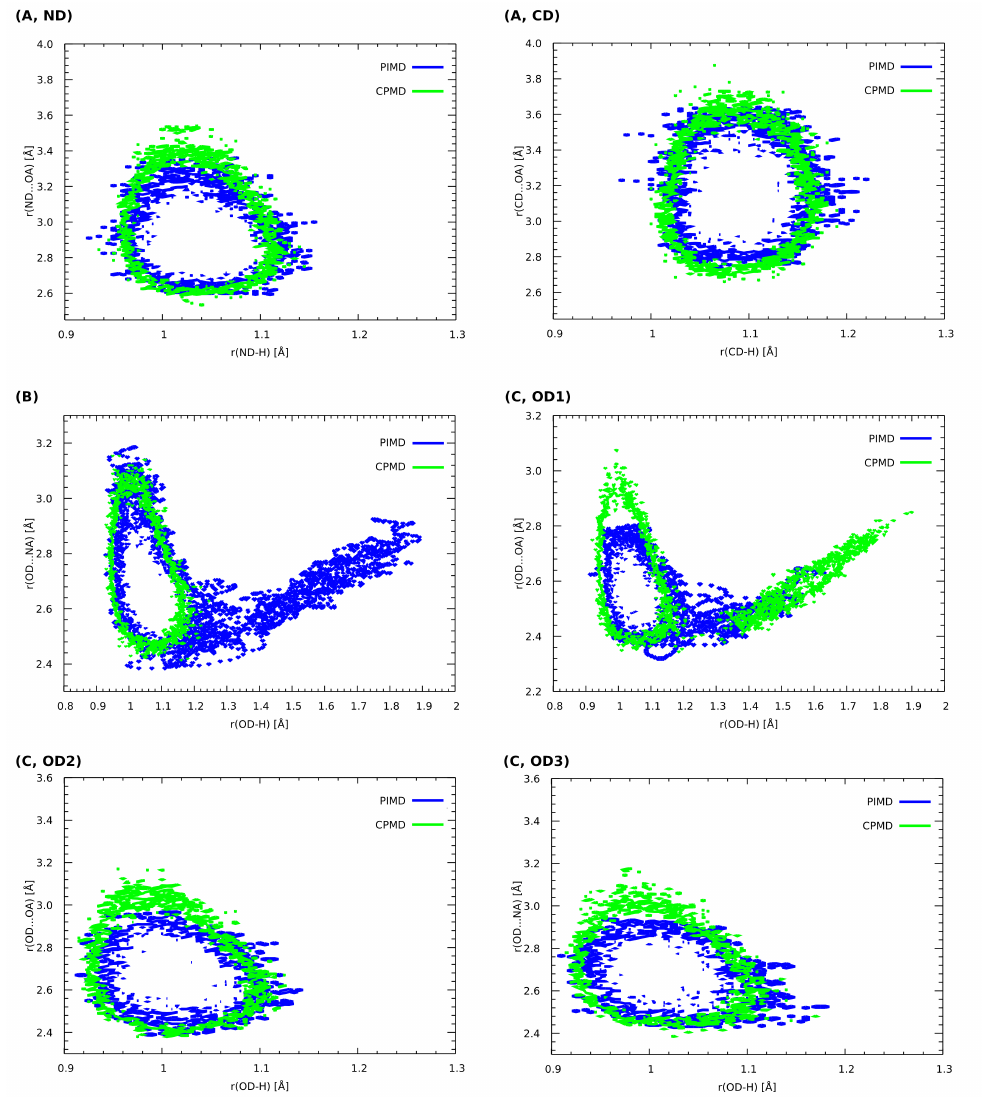
Figure 4. Histograms presenting the relationship between the length of the corresponding donor– proton covalent bonds as well as the distance between the proton and its acceptor. CPMD vs. PIMD in the crystalline phase. ( A ) 2,6-difluorobenzamide, ( B ) 5-hydroxyquinoline and ( C ) 4- hydroxybenzoic acid. ND, OD and CD indicate proton donors. Probability density isocontours drawn at the 1 Å − 2